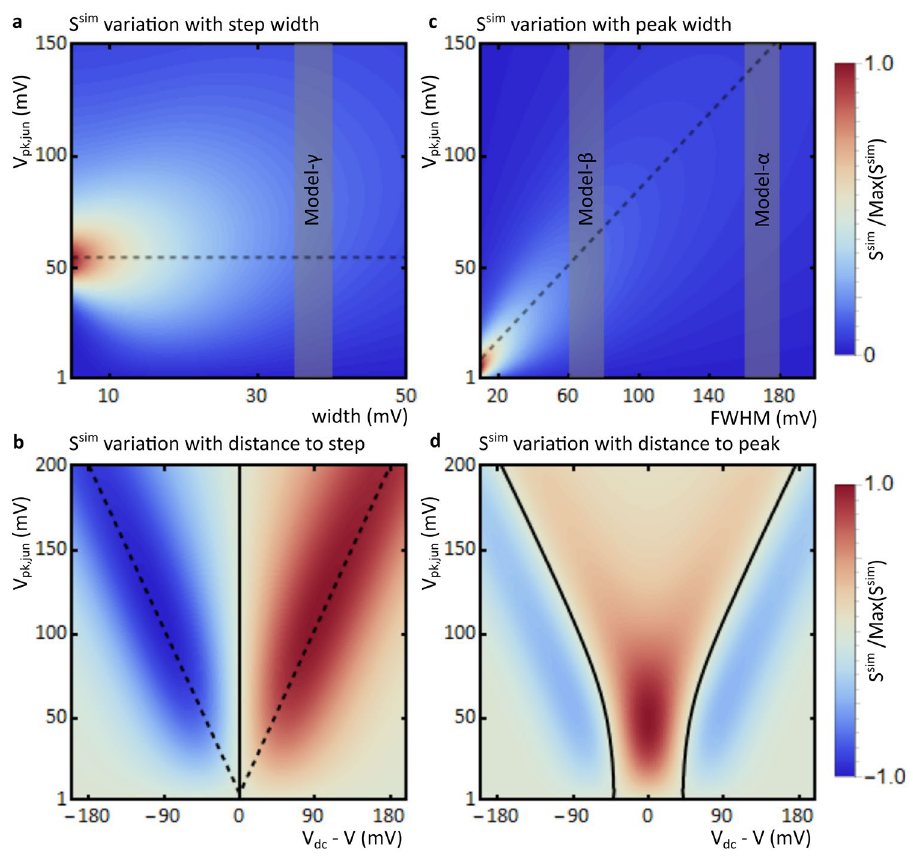
S sim V pk,jun , width Figure 3. Simulated parameter maps ( a ) A parameter map of normalised for a sigmoid (cid:29)(cid:31) (cid:31) (cid:30) function step G sim ( V DC ) spectrum at V DC -50 mV. Red colours correspond to maximum sensitivity towards (cid:31) (cid:31) = V pk,jun . The grey area indicates the width of the experimental model-γ and the dashed line corresponds to a V pk,jun , V DC value of V pk,jun = | V DC |+ 5 mV. ( b ) A parameter map of normalised S sim for a sigmoid function (cid:31) (cid:30) step G sim ( V DC ) spectrum at a step width of 37 mV. Red and blue colours correspond to maximum positive and negative sensitivity towards V pk,jun , respectively. The solid black line represents zero sensitivity and the V DC dashed line again corresponds to a value of V pk,jun 5 mV. ( c ) A parameter map of normalised |+ = | S sim V pk,jun , FWHM for a Gaussian peak G sim ( V DC ) spectrum at V DC 0 mV. The grey areas indicate (cid:29)(cid:31) (cid:31) = (cid:30) the FWHM of the experimental models β and α and the dashed line corresponds to a value of V pk,jun (cid:31) (cid:31) = V pk,jun , V DC 0.85∙FWHM. ( d ) A parameter map of S sim for a Gaussian peak G sim ( V DC ) spectrum at a FWHM (cid:31) (cid:30) of 70 mV. The solid black line represents zero